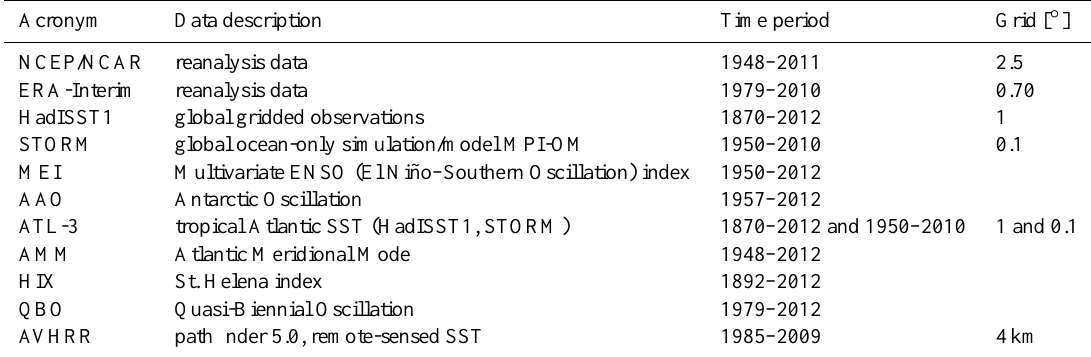
Table 1. Description of the data sets used in this